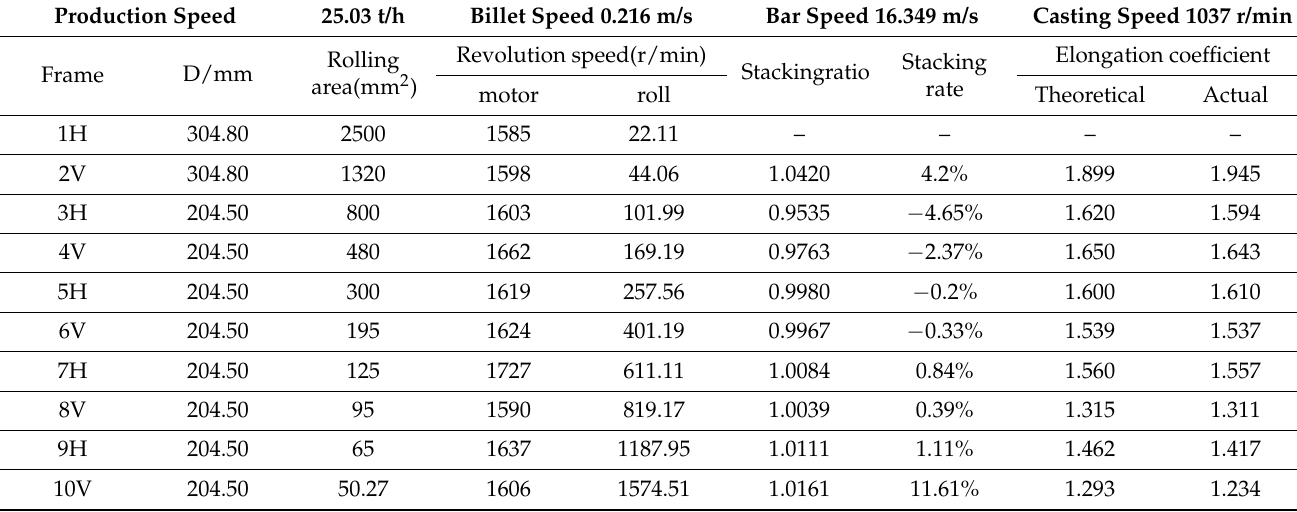
Table 3. Matching table for extension coefficient of stands of continuous rolling mill in the SCR3000 production line. Production